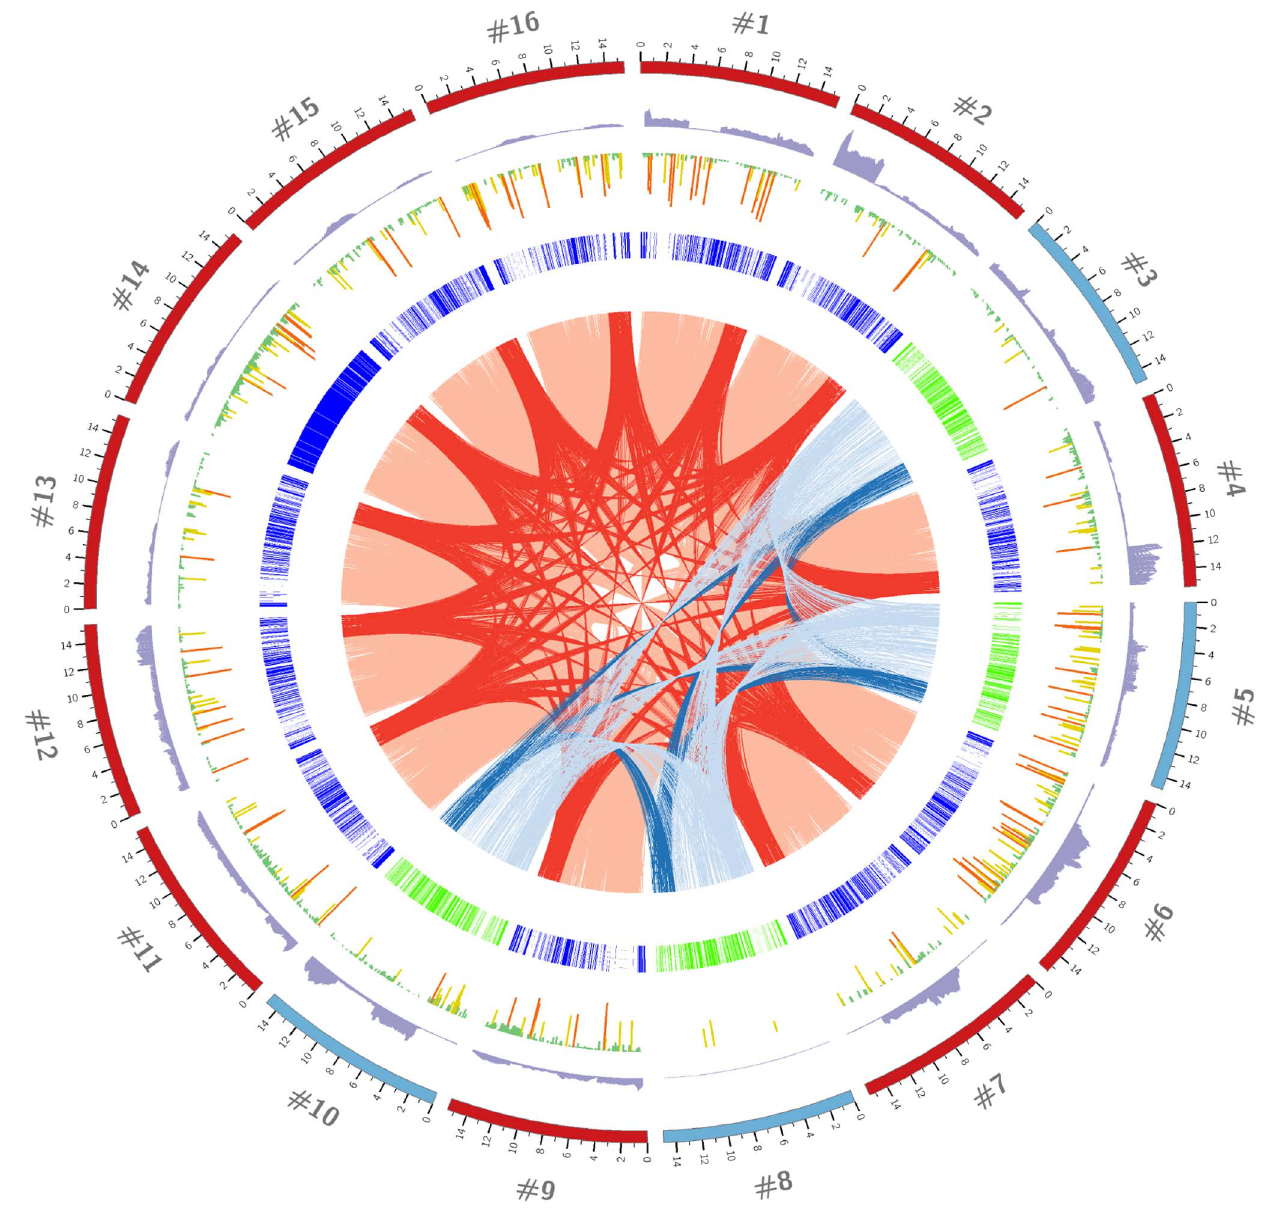
Figure 1. Deep sequencing of HK PRRSV strains. Shown from the periphery to the centre of the figure for each strain is strain ID, genome ideogram (blue for type 1; red for type 2), sequencing depth across the genome, minor variants detected across the genome with at least 1% frequency ( , 10% in green, . =10% in yellow, . =30% in red), amino acid comparisons (green for type 1; blue for type 2) with reference strains (LV for type 1; ATCC VR2332 for type 2) for individual ORFs across the genome (non-conformity represented by white streaks), and pairwise aligned amino acid differences between sequenced strains for individual ORFs (non-structural ones in light shade; structural ones in dark shade) across the genome (blue for type 1; red for type